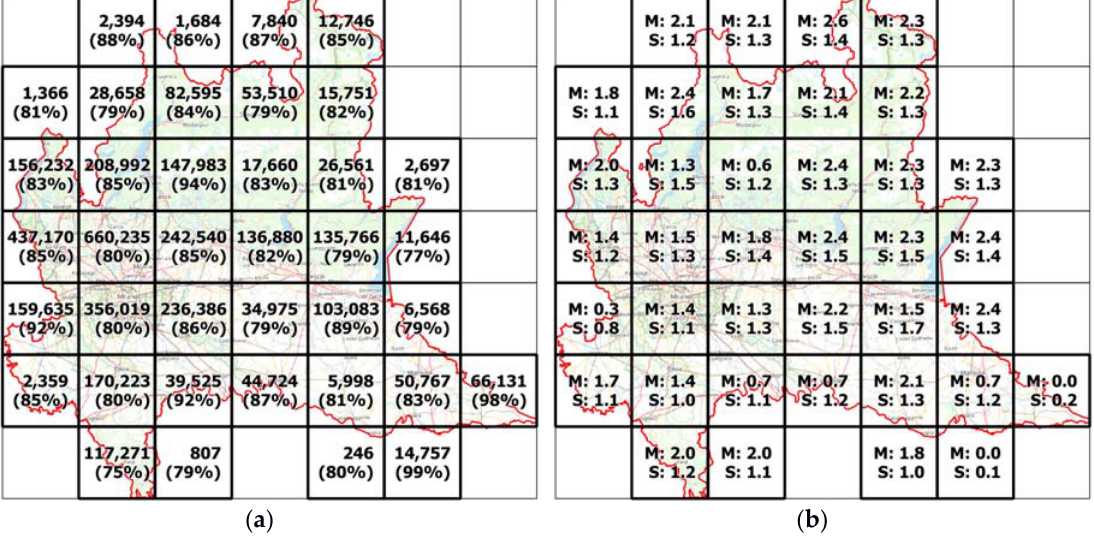
Table 1. Points distance statistics for the whole Lombardy region.